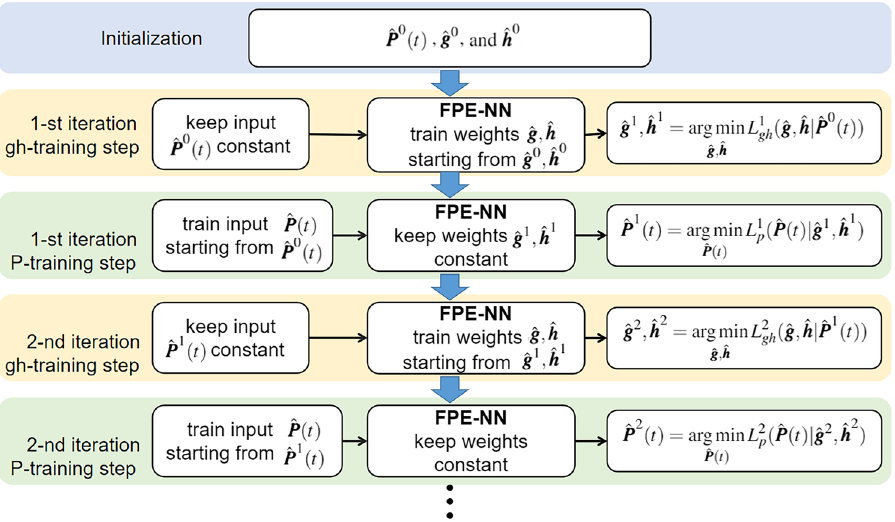
Figure 1. Flowchart of using FPE-NN to train the input ˆ P ( t ) and the weights ˆ g , ˆ h in an alternating way. Each iteration consists of two steps, first the gh-training step then the P-training step. The counting of iteration 0 0 ( t ) , ˆ g 0 and ˆ h starts from 1, as ˆ P are the initialized values. In the k -th iteration, the updated input and weights k − 1 k − 1 ( t ) , ˆ g k − 1 , and ˆ h in the previous iteration are ˆ P , respectively. We first keep ˆ P the accuracy of the weights in the gh-training step, and save the trained weights as ˆ g k and ˆ h k and ˆ h constant to improve the accuracy of the input in the P-training step, and save the trained input as ˆ P k k ( t ) , ˆ g k , and ˆ h Subsequently, ˆ P are used for the next